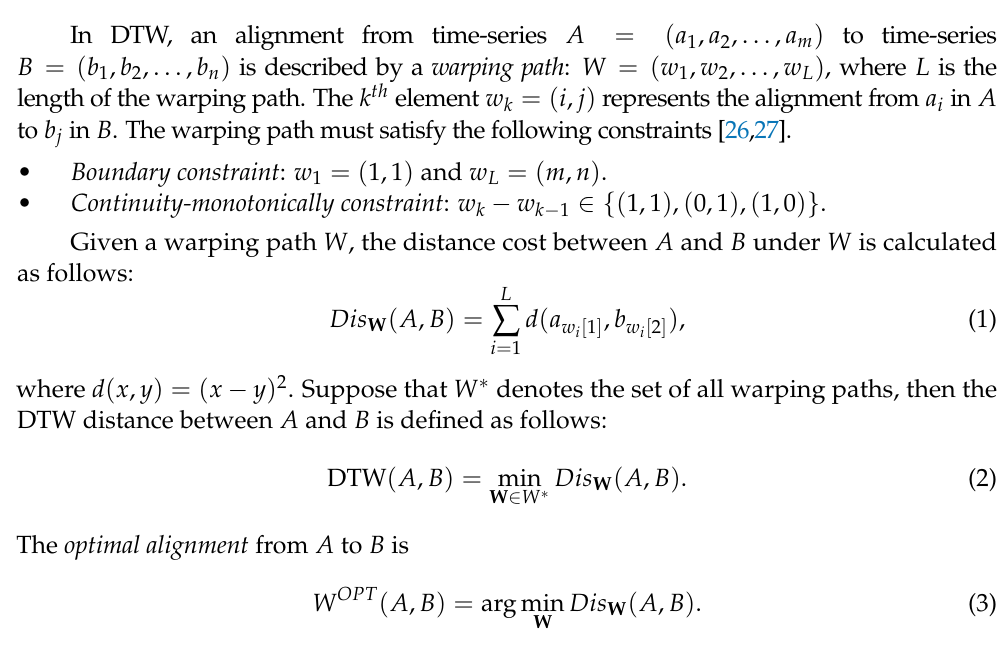
Figure 5. An optimal alignment generated by DTW ( left ), and a strictly time-rigid alignment generated by Euclidean Distance ( right